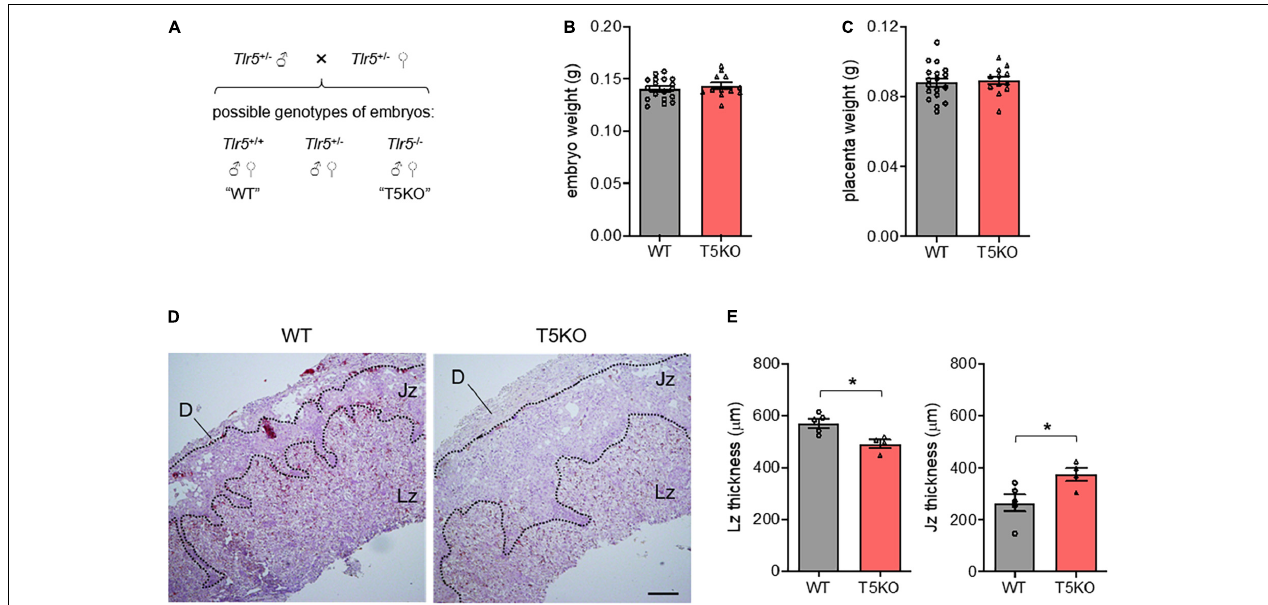
FIGURE 3 | The proper development of labyrinthine zone relied on the fetal expression of TLR5. (A) A schematic diagram depicting possible outcomes of fetal genotypes, namely Tlr5 + / + (wild type, WT), Tlr5 − / − (TLR5-knockout, T5KO) and Tlr5 + / − (heterozygous T5KO) is shown. Heterozygous Tlr5 + / − mice were mated and sacrificed at embryonic day 13.5. Genotypes of individual embryos were determined. (B,C) The (B) embryo and (C) placenta weights were measured ( n = 18 embryos for WT, n = 12 embryos for T5KO, from 5 litters). (D,E) Placenta sections were subjected to hematoxylin-eosin staining. (D) Representative images are shown. Scale bar is 200 µ m. Maternal decidua (D), junctional zone (Jz) and labyrinthine zone (Lz) are denoted. (E) Thicknesses of Lz and Jz were measured. Each dot represents the average thickness for one litter ( n = 5 litters). Data are represented as mean ± SEM. The differences between WT and T5KO mice were determined by two-tailed Student’s t -test. * P <